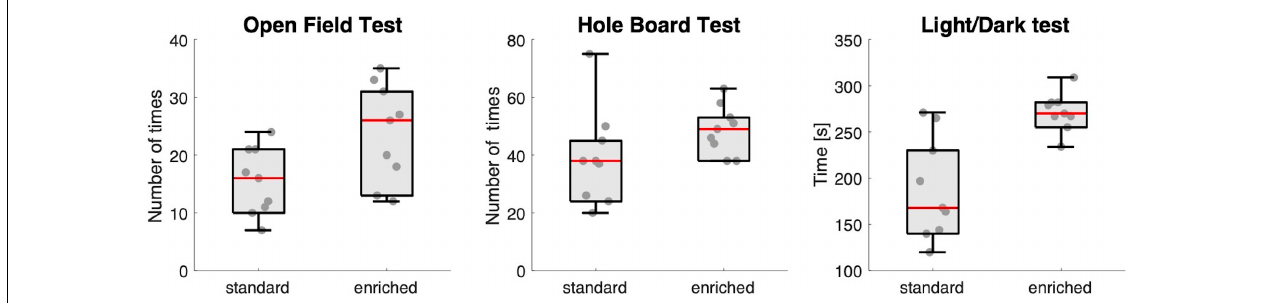
FIGURE 2 | Explorative behavior. Box-and-whisker plots showing the results of the three behavioral tests for the two groups of mice (standard and enriched). Each dot is an individual mouse. The red line in the box is the median value of the group.